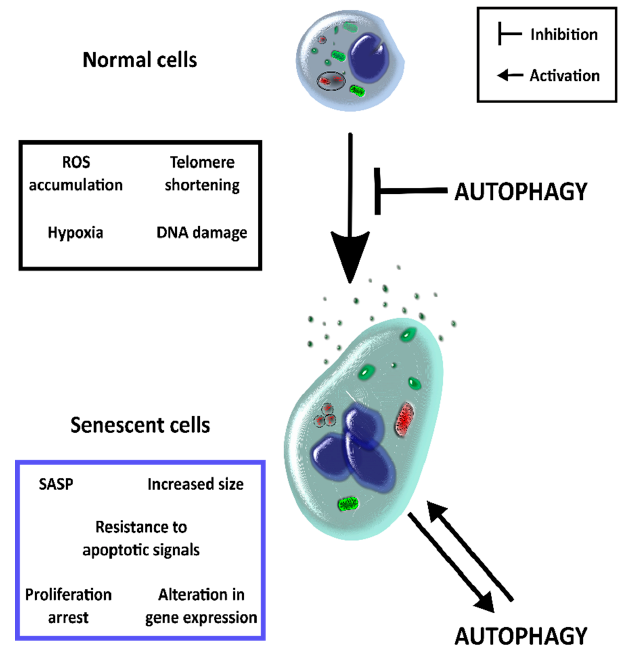
Figure 2. Autophagy has a dual role in senescence activation. There are several factors that